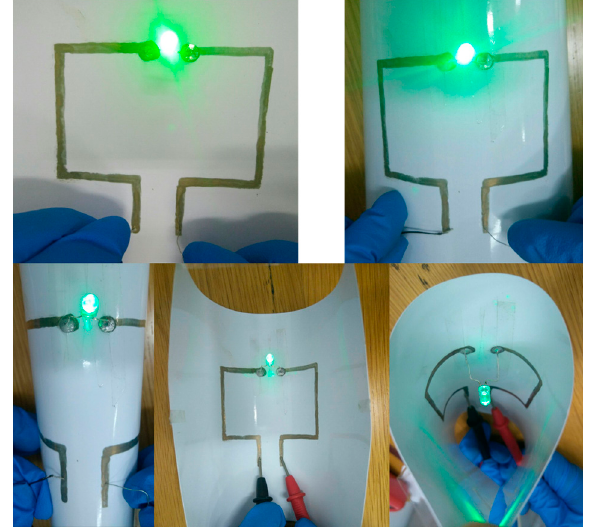
Figure 10. Optical images of light emitting devices with the AgNW conductive circuit on photographic paper.